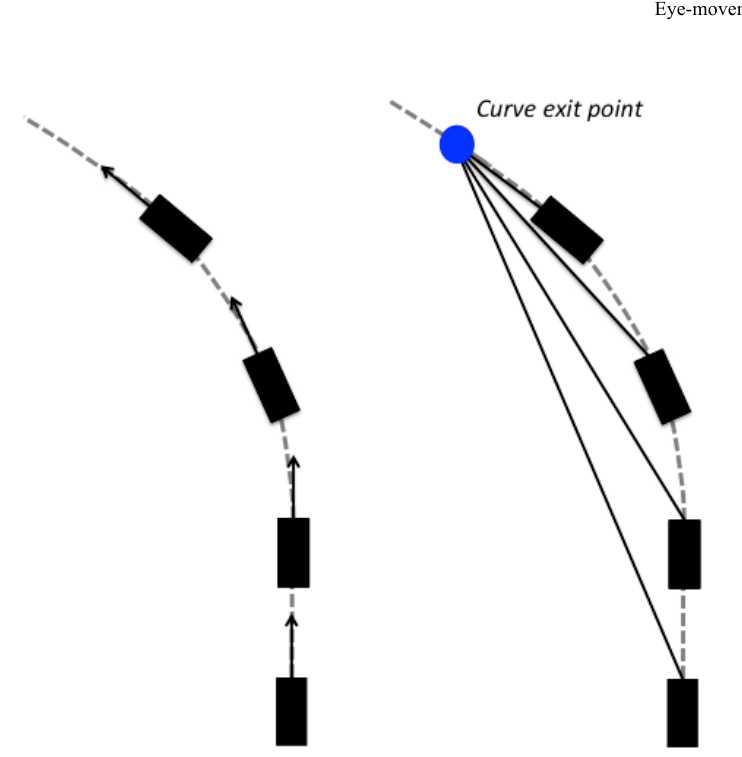
Figure A4. Left. The zero visual angle reference-direction in the vehicle frame of reference corresponds to the car’s longitudinal axis, which is approximately equivalent with instantaneous heading on the trajectory (cf. figure 2, Results, Top). Right: The gaze data was transformed into a rotating coordinate system referenced to the curve exit point, a fixed, static point in the world that met the conditions of falling on the future path of the vehicle as well as being visible throughout the entire duration of the bend. (cf, Figure 2,results,